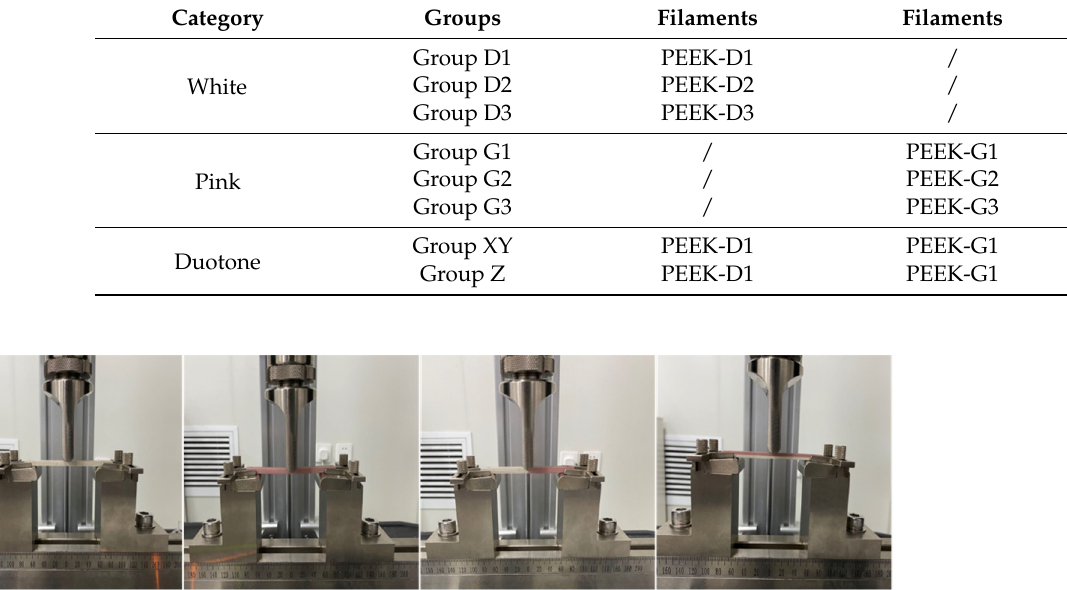
Table 4. Groups in the mechanical tests and the filaments used.